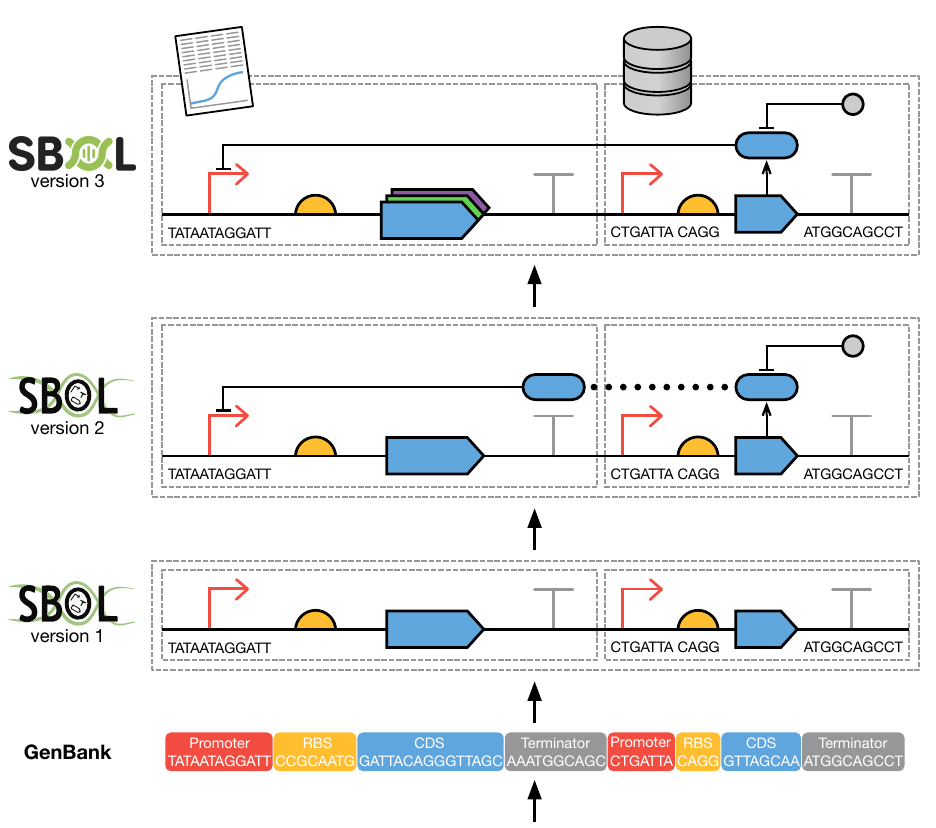
Figure 1: SBOL extends prior sequence description formats to represent both the structure and function of a genetic design in a modular, hierarchical manner, as well as its relationship to, and use within, experiments, plans, data, models,